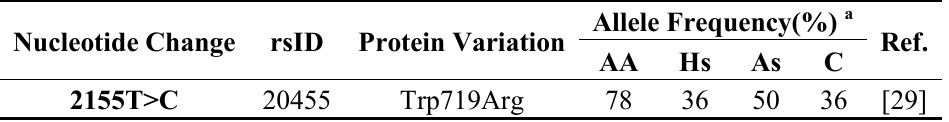
Table 1. KIF6 Genotypes in Various Ethnic